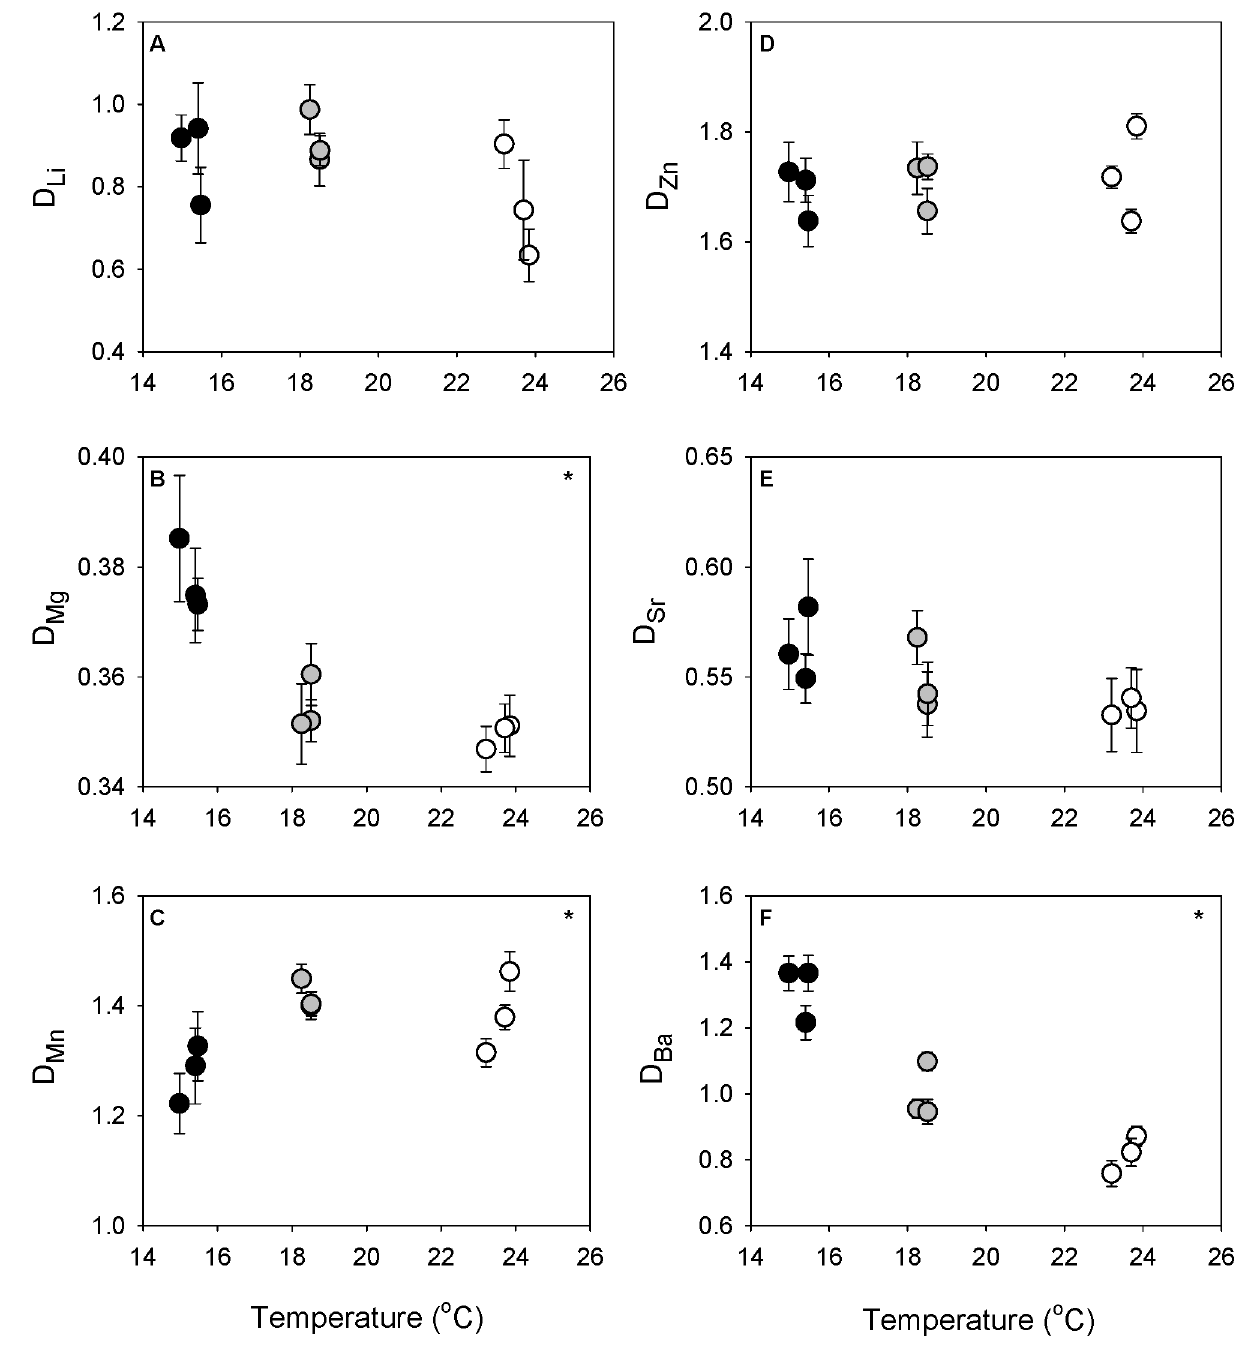
Figure 3. Influence of temperature treatment on elemental partitioning. Mean ± standard error of partition coefficients (D (A) lithium, (B) magnesium, (C) manganese, (D) zinc, (E) strontium, and (F) barium by treatment and mean tank temperature. Black circles represent 15°C treatments, grey circles 18°C treatments, and open circles 24°C treatments. Significant responses of D temperature are indicated by (*).